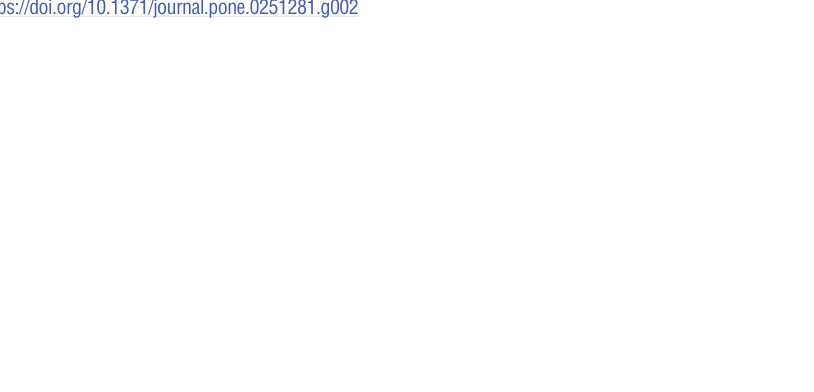
PLOS ONE | https://doi.org/10.1371/journal.pone.0251281 May 6,